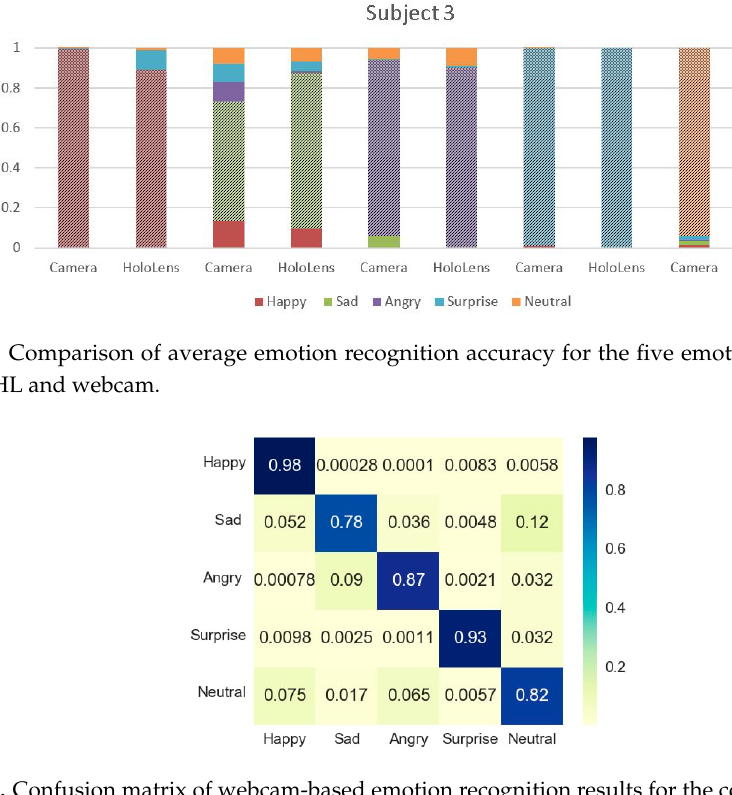
Figure 7. Confusion matrix of webcam-based emotion recognition results for the complete dataset.